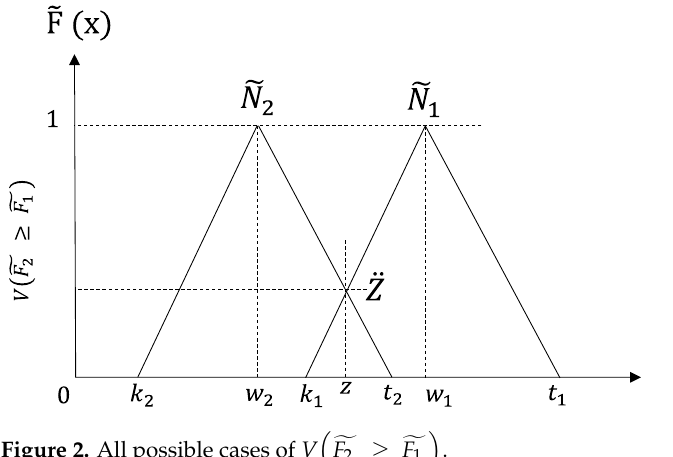
(cid:16) (cid:17) (cid:102) F 2 ≥ (cid:102) F 1